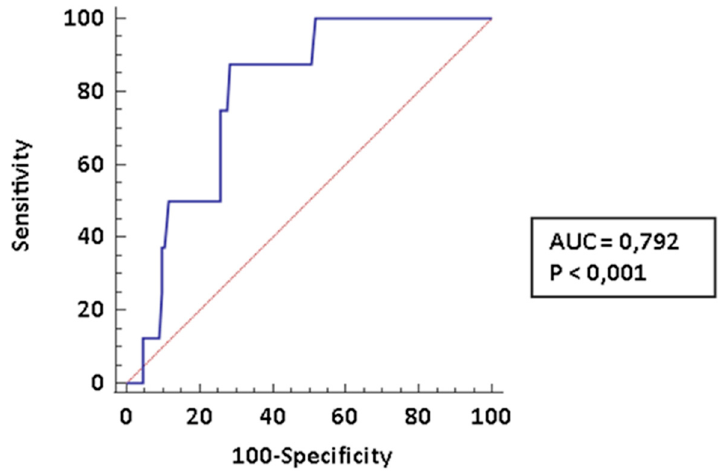
Figure 3. ROC curve for basal PetCO 2. We diagnosed 8 CTD-PAH.